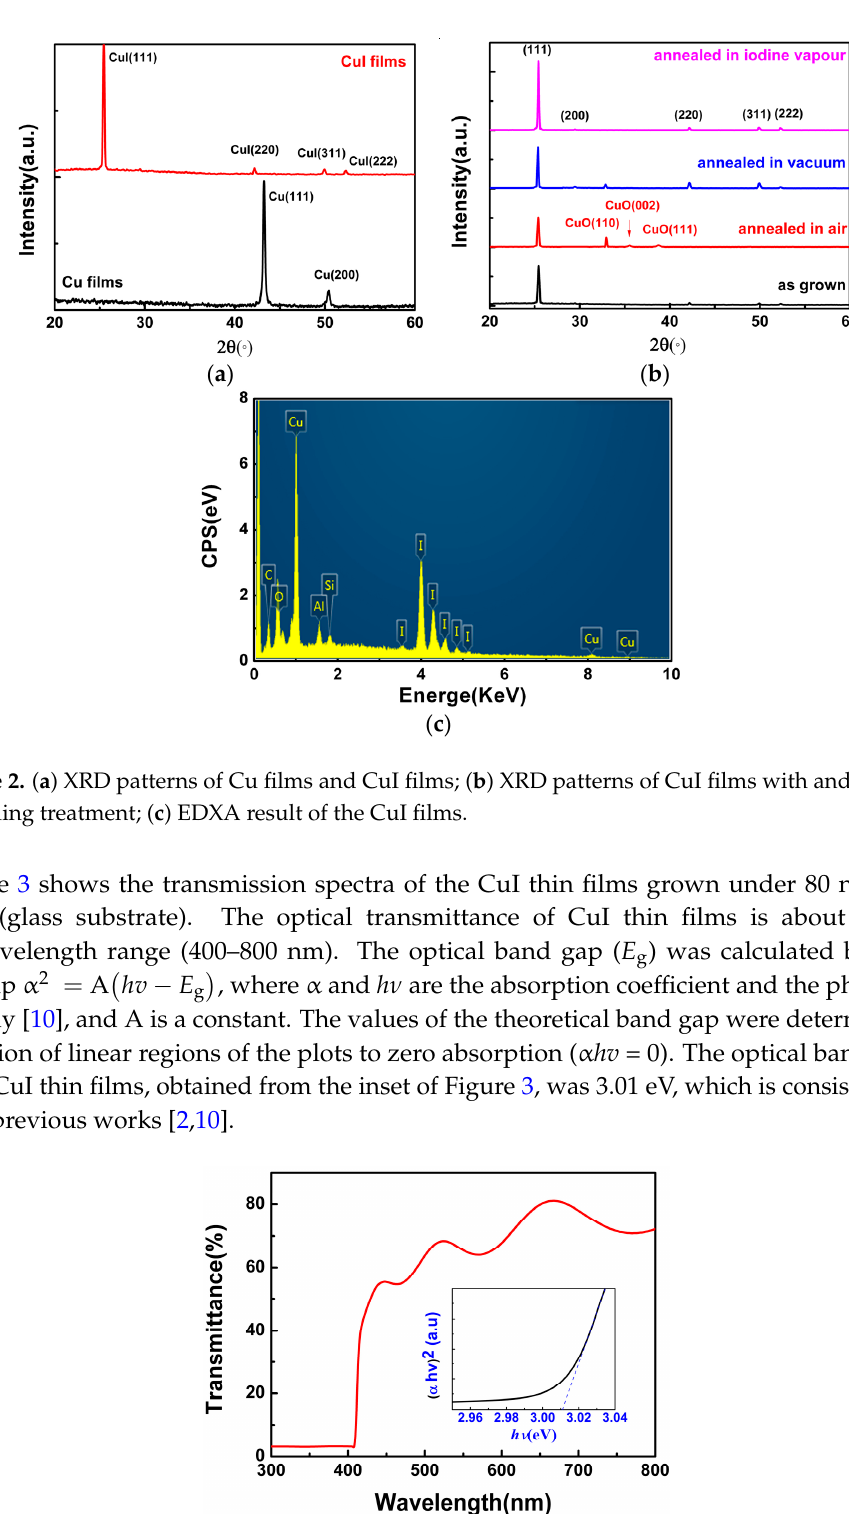
Figure 3. Transmission spectra of the CuI thin films, the inset shows the optical band gap of CuI thin films grown on glass substrate.